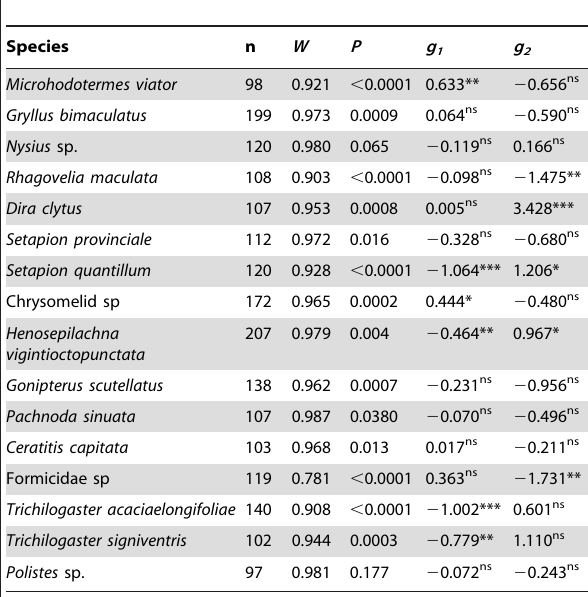
Table 5. Outcome of the assessment of deviation from normality (Shapiro-Wilks W statistic) and the degree of skewness ( g 1 ) and kurtosis ( g 2 ) for the log transformed body size frequency distributions based on the linear measures made for all 16 insect species